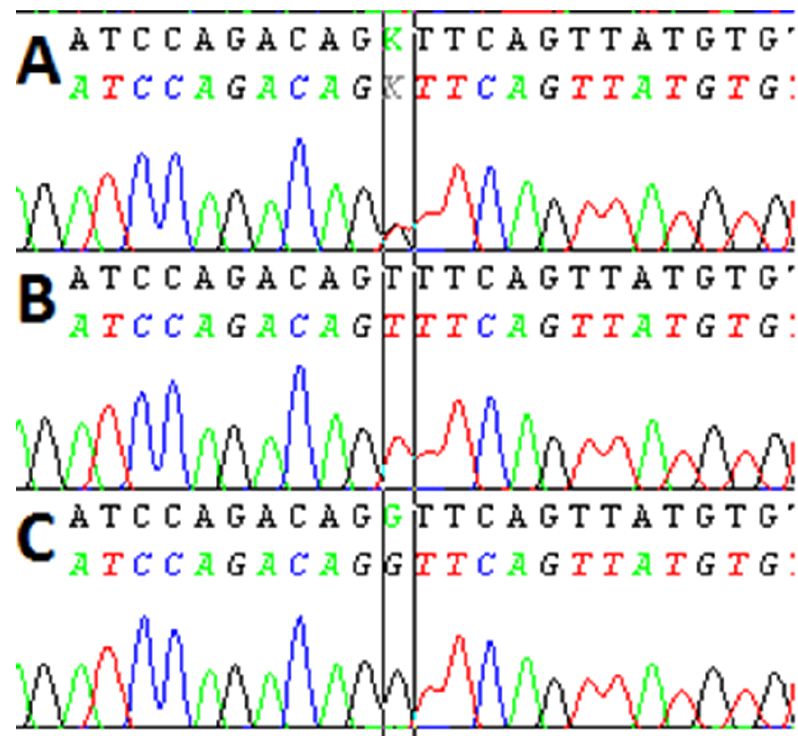
Figure 1. An example of the TNFRSF1A gene sequencing. ( A – C ) demonstrate the GT, TT, and GG genotypes of studied SNP (rs4149570), respectively. Specific variants were marked with a black box. Abbreviations: A-green, T-red, C-blue, G-black.